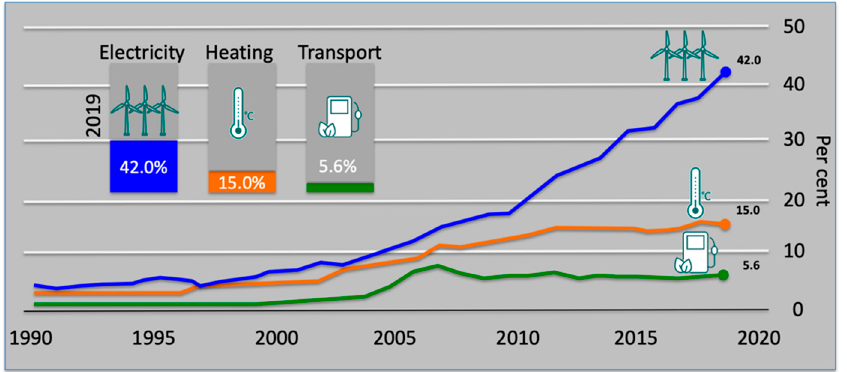
Figure 2. Shares of renewable energies in Germany in the areas of electricity, heat and transport from 1990 to 2019. (Own presentation based on data from the German Federal Environment Agency 2020: https://www.umweltbundesamt.de/ (accessed on 9 June 2021)). Table 1. Energy and climate policy objectives of the German government in the 2010 Energy Concept.